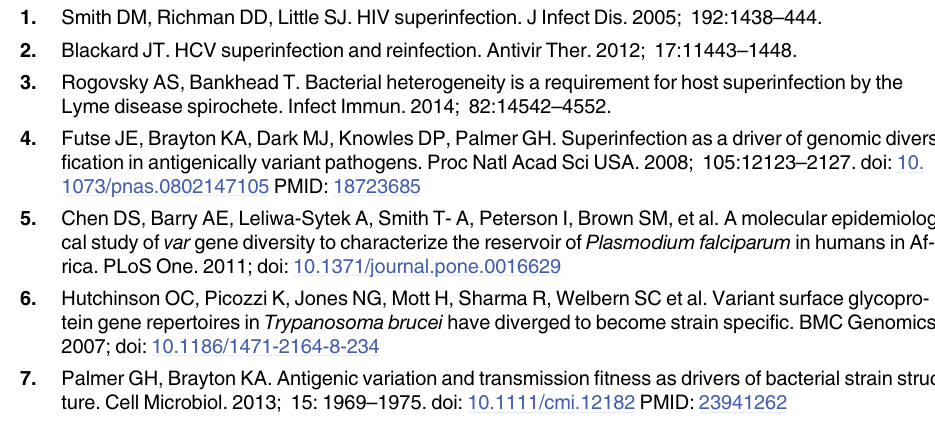
S1 Table. A . marginale msp1 α genotypes present in singly and superinfected cattle in El Verdineño (Nayarit). The unique variable repeat sequence is designated by a letter, number, or alphanumeric combination. The sequences have been deposited in GenBank and the acces- sion numbers are provided in S3 Table. The msp1 α genotype is designated by the number and order of the repeats, listed 5 ’ to 3 ’ . S2 Table. A . marginale msp1 α genotypes present in singly and superinfected cattle in La Joya (Jalisco). The unique variable repeat sequence is designated by a letter, number, or alpha- numeric combination. The sequences have been deposited in GenBank and the accession num- bers are provided in S3 Table. The msp1 α genotype is designated by the number and order of the repeats, listed 5 ’ to 3 ’ . S3 Table. A . marginale msp1 α repeat sequences in the current study. The repeat designation, strain name and location of first reported isolation, and GenBank accession number. S4 Table. Unique A . marginale Msp2 hypervariable regions identified in the current study. The animal number, GenBank accession number, and encoded hypervariable